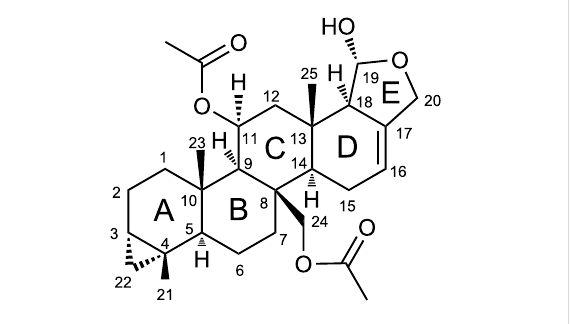
Figure 2: The structurally new 12-deacetoxy-4-demethyl-11,24-diace- toxy-3,4-methylenedeoxoscalarin (relative stereochemistry depicted), isolated from Doriprismatica stellata nudibranchs, their egg ribbons and the dietary sponge Spongia cf. agaricina